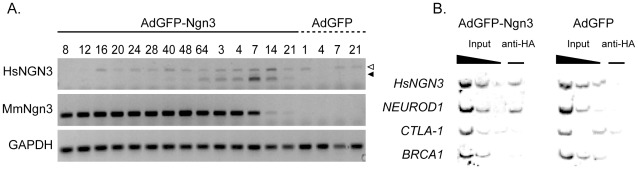
Ngn3 induces its own expression via direct binding on its own promoter.(A) RT-PCR detection of exogenous and endogenous Ngn3 in AdGFP-Ngn3 transduced duct cells. Time course detection of exogenous HA-Ngn3 and endogenous Ngn3 mRNA showing sustained endogenous Ngn3 expression. Time points are indicated in hours (8–64) or days (1–21). Open triangle: genomic Ngn3 PCR fragment; black triangle: endogenous Ngn3 cDNA PCR fragment. Gapdh-specific RT-PCR is included as template control (n = 3). (B) Chromatin immunoprecipitation with an anti-HA antibody on chromatin derived from adult human duct cells transduced with either AdGFP-Ngn3 or AdGFP. DNA from input chromatin was serially diluted as a reference for semiquantitative PCR analysis. In the AdGFP-Ngn3 samples both NGN3 and NEUROD1 promoter fragments are enriched with antibodies directed against the HA tag, suggesting that Ngn3 binds both endogenous wild type promoters. NGN3 and NEUROD1 promoter fragments were not detected in AdGFP control samples, neither were the negative control genomic fragments from the CTLA-1 and BRCA1 genes (n = 2).